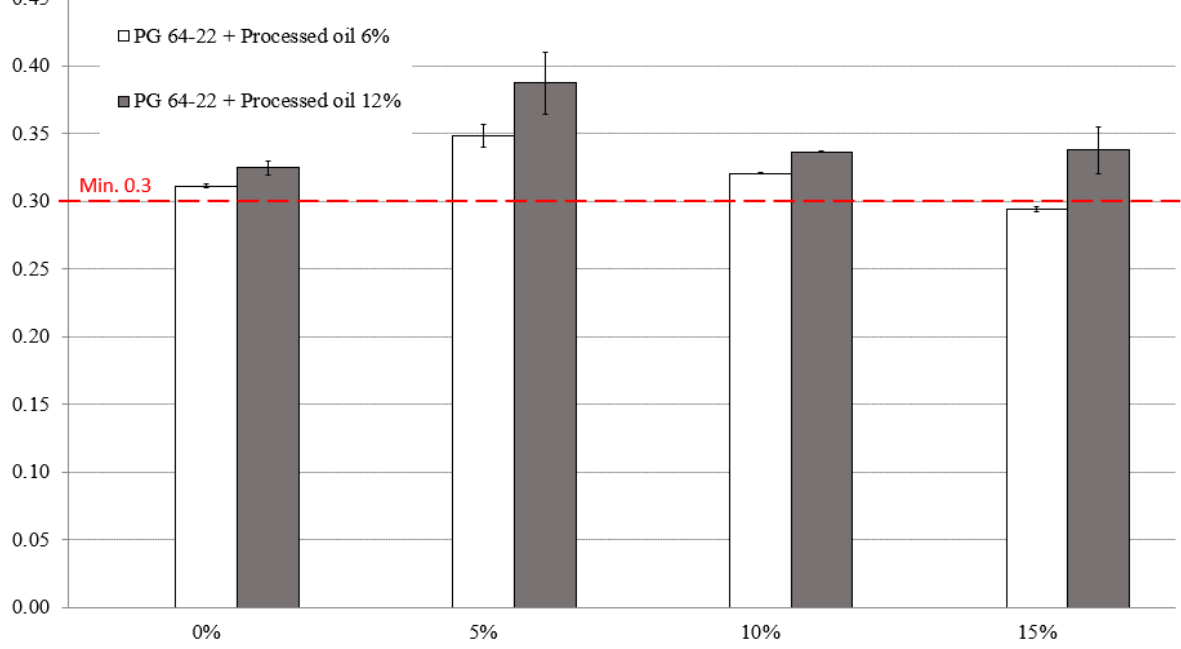
Table 12. Statistical analysis results of stiffness for RTFO + PAV aged PG 64 ‐ 22 with processed oil as a function of SBS content at − 24 °C ( α = 0.05).